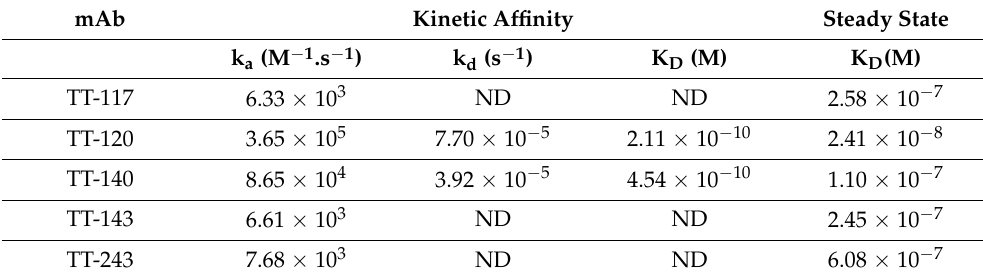
Table 1. Ka, kd, and KD(M) were calculated from each mAb by kinetic and steady-state affinity assay. mAb Kinetic Affinity